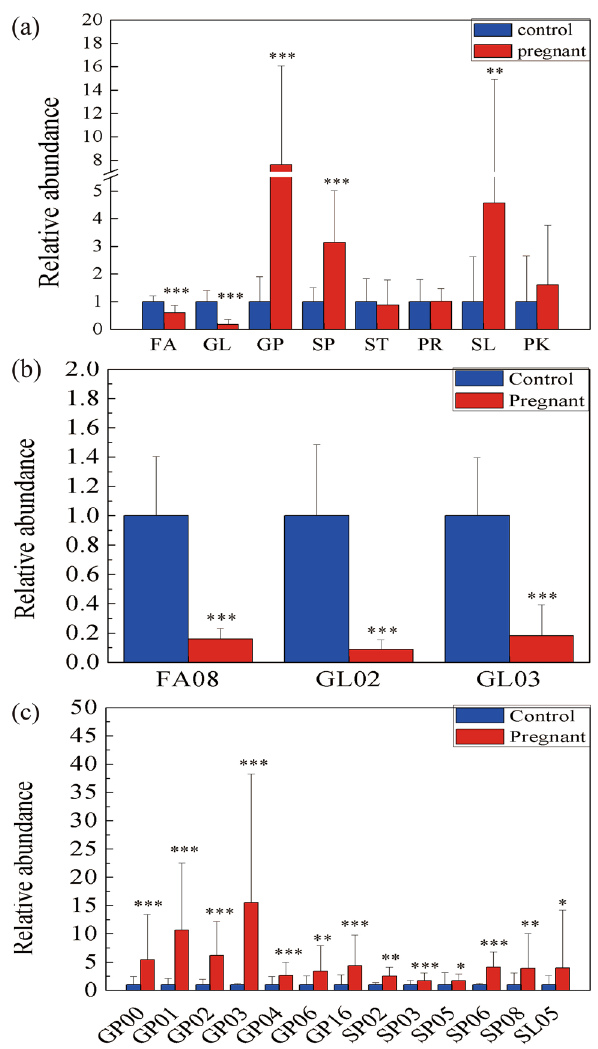
Figure 2. ( a ) The relative amounts of the eight major lipids in the pregnant and control groups. ( b ) 3 subclasses in fatty acyls (FA) and glycerolipids (GL) of the relative amounts significantly decreased. ( c ) 13 subclasses in 3 main classes (glycerophospholipids (GP), sphingolipids (SP), and saccharolipids (SL)) of the relative amounts significantly increased. *** p < 0.001, ** p < 0.01, * p <